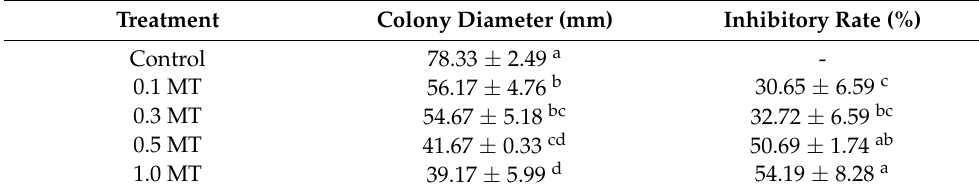
Table 1. In vitro inhibition of B. dothidea by different concentrations of MT.